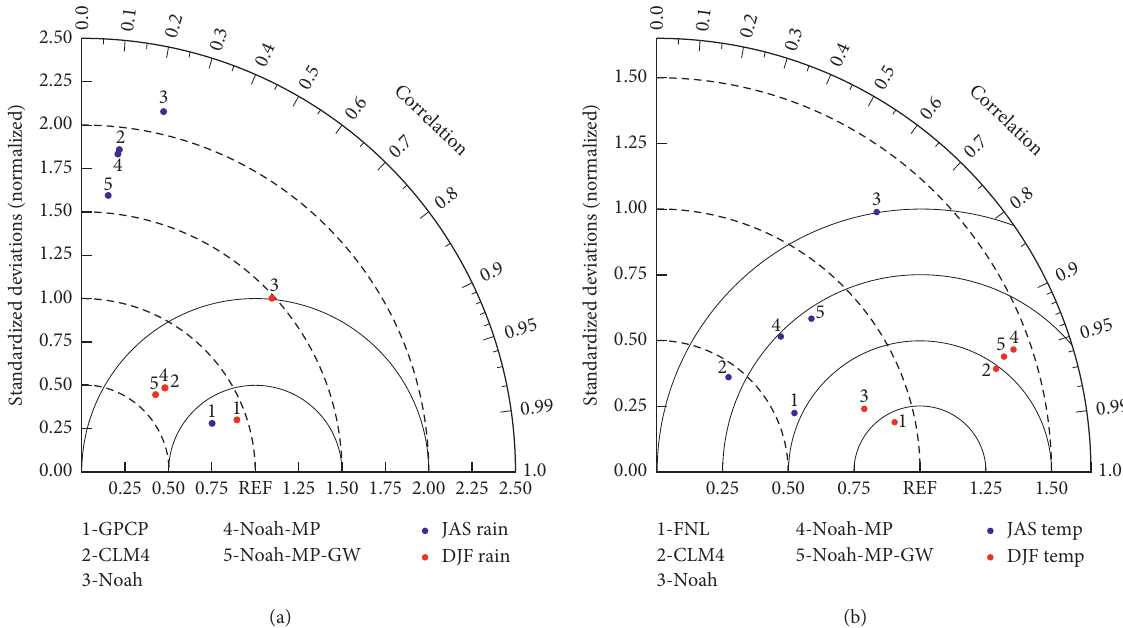
Figure 12: Taylor diagrams for comparison: (a) precipitation (REF is TRMM); (b) surface air temperature (REF is ERA-Interim) (blue colours are for the rainy season and red colours are for dry season). The RMS error and the standard deviation have been normalized according to [95] before plotting the Taylor